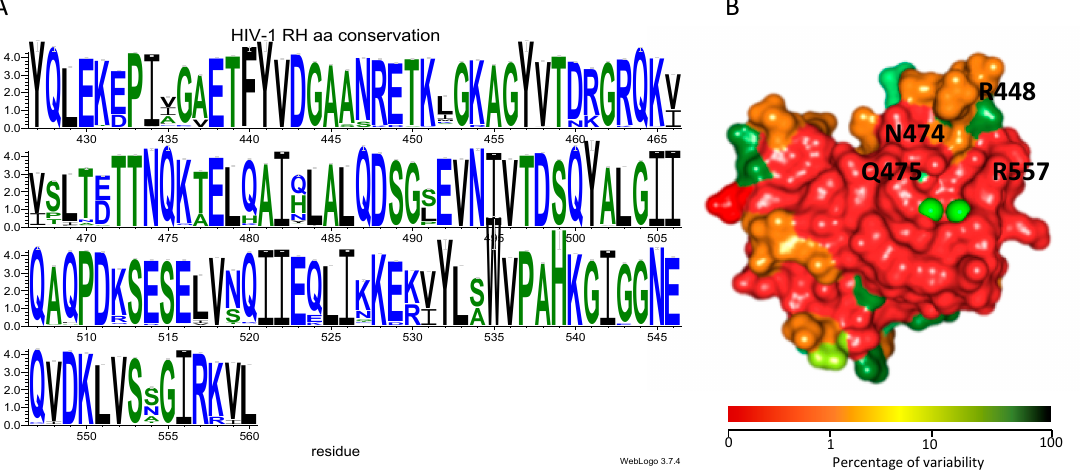
Figure 5. Conservation profile of HIV-1 RT RNase H domain. ( A ) Logo of degree of conservation of amino acid residues: blue hydrophobic lateral chains, green neutral lateral chains, black hydrophilic lateral chains; ( B ) color scheme of the percentage of variability of HIV-1 RT RNase H domain (PDB code 3K2P). The color scale of the percentage of variability goes form red (low percentage of variation) to green (high percentage of